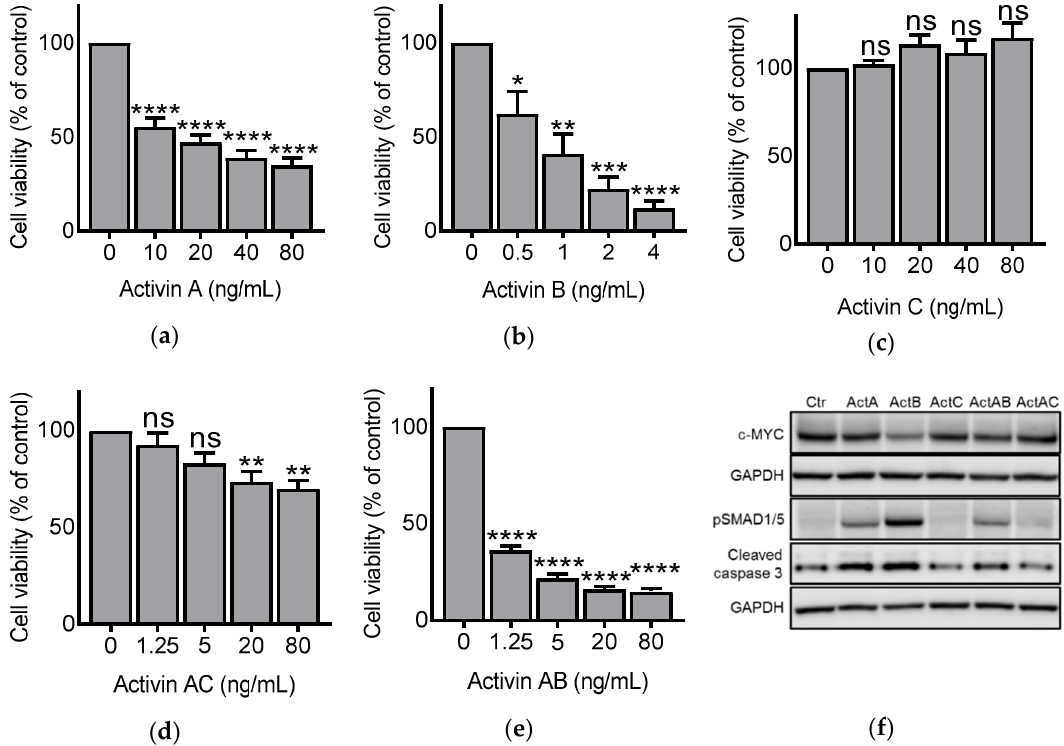
Figure 1. Impact of activin homo- and heterodimers on IH-1 cell viability. IH-1 myeloma cells were treated for three days with increasing doses of activins as indicated in the figure. Cell viability was measured using CellTiter Glo and the results are plotted relative to control ( a – e ). The graphs represent mean ± standard error of the mean (s.e.m.) of n = 3 independent experiments. One-way ANOVA and Dunnett’s multiple comparisons test were performed (* p ≤ 0.05, ** p ≤ 0.01, *** p ≤ 0.001, **** p ≤ 0.0001, ns (not significant) p > 0.05). ( f ) We also treated IH-1 cells for 24 h with activin A (20 ng / mL), activin B (4 ng / mL), activin C (20 ng / mL), activin AB (5 ng / mL) or activin AC (20 ng / mL), and did western blot to look at di ff erences in expression of c-MYC, phospho-SMAD1 / 5 (pSMAD1 / 5) and cleaved caspase 3, with GAPDH as the loading control. The blots shown are representative of n = 3 independent experiments.